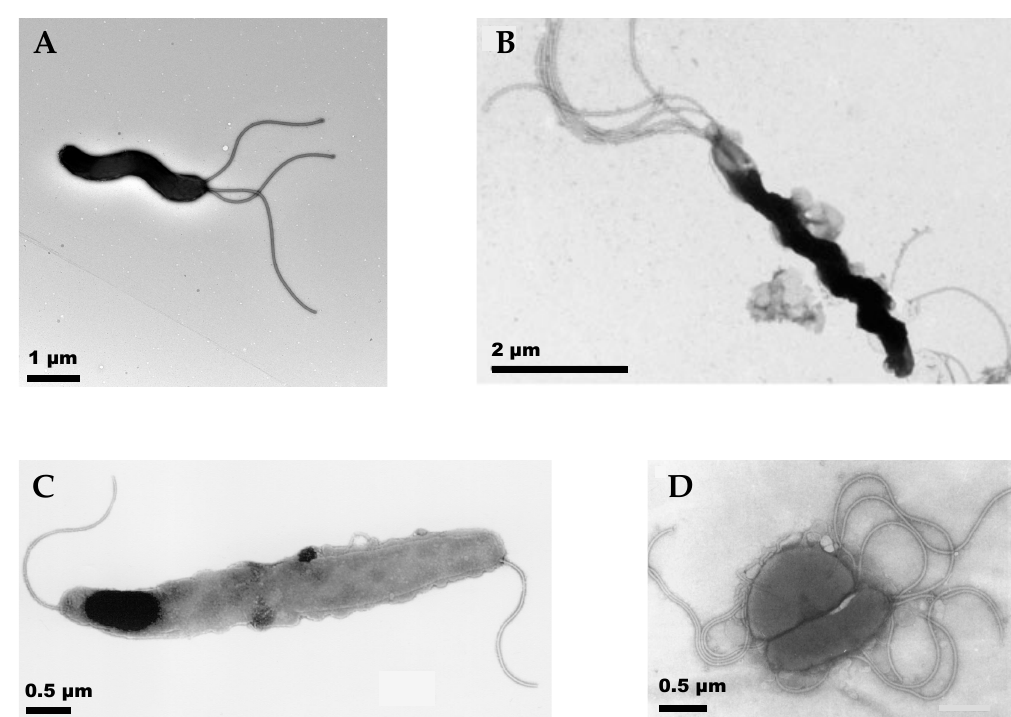
Figure 1. TEM images of different Helicobacter spp. showing flagella at different locations on the cell body. ( A ) H. pylori , scale bar 1 μ m [4]. ( B ) H. suis , scale bar 2 μ m. The flagella at the lower end are not fully visible in the image [5]. ( C ) H. cetorum , scale bar 0.5 μ m [6]. ( D ) H. mustalae , scale bar 0.5